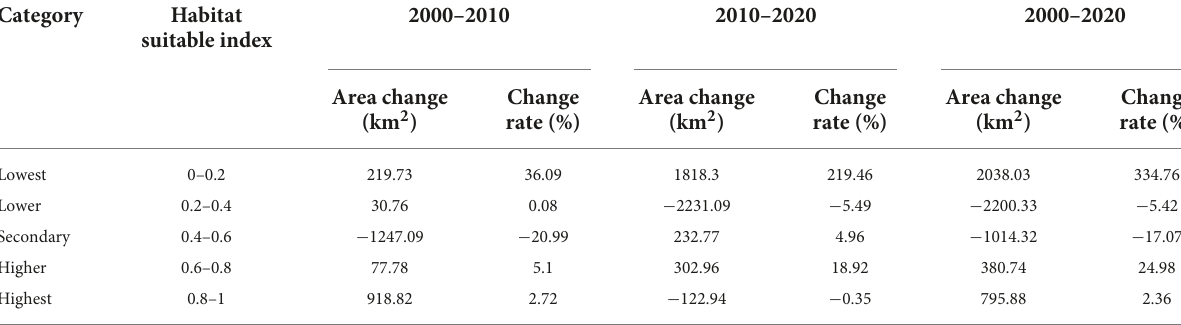
TABLE 4 Habitat changes at different stages in Chongqing